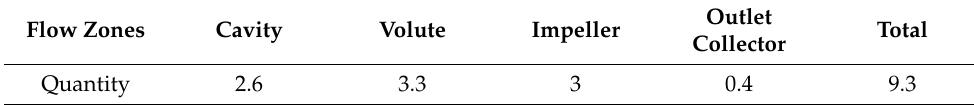
Figure 7. Independent grid validation. Table 3. Grid quantity (unit: million).